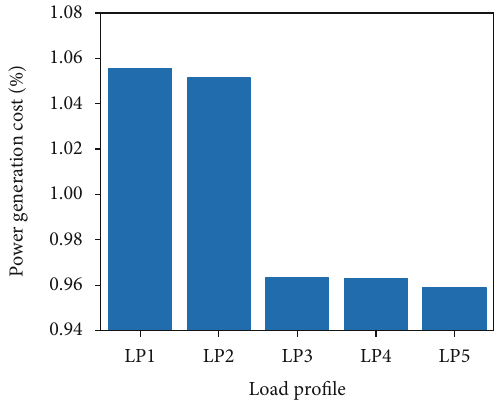
Figure 10: Power generation costs of the 24h DEDs of the various load pro fi les (LPs) at 40% solar penetration under abundant solar resource